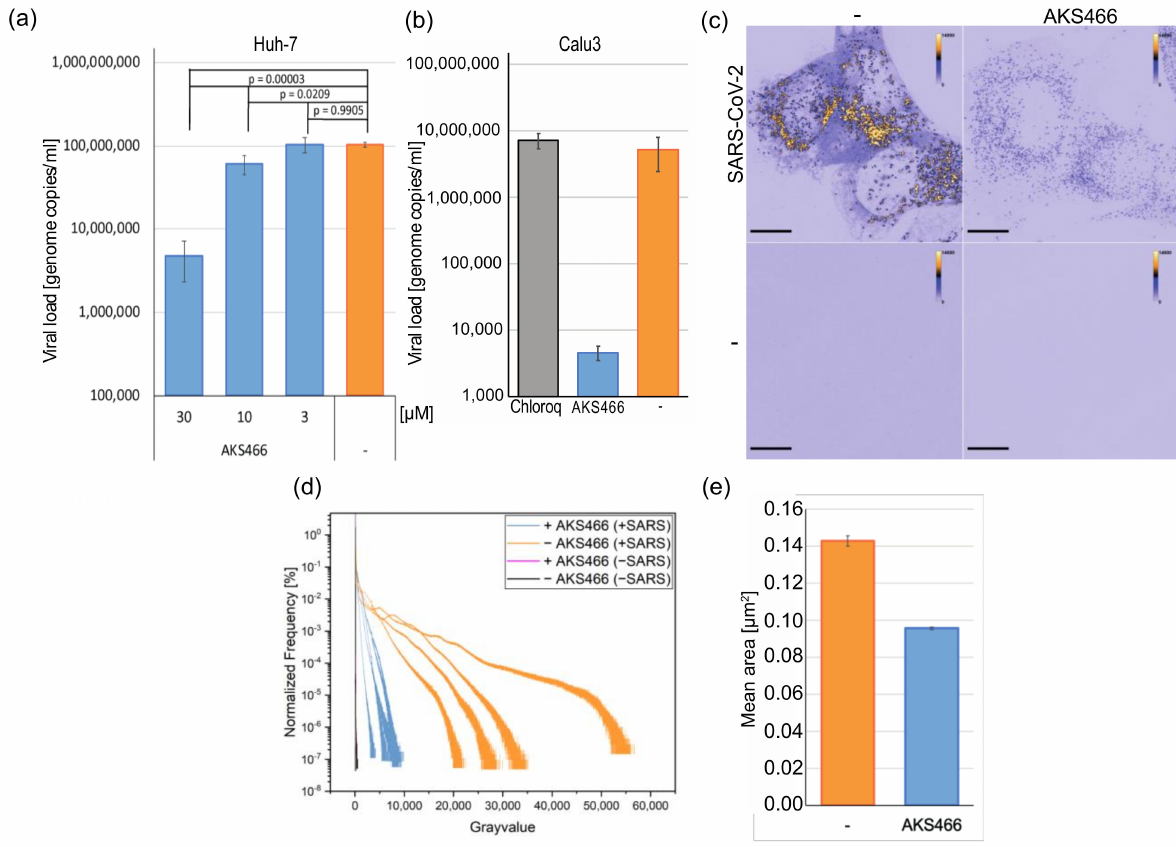
Figure 3. AKS466 inhibits SARS-CoV-2 replication. ( a ) Huh-7 were incubated with 3, 10, 30 µ M AKS466, and ( b ) Calu-3 cells were incubated with 30 µ M AKS466 and infected with 0.5 µ L SARS-CoV- 2. Cell culture supernatants were harvested after 3 days, and viral loads were determined by RTqPCR. Chloroq: Chloroquine (30 µ M). ( c ) Maximum intensity projections of SARS-CoV-2 FISH confocal fluorescence images of Huh-7 cells. In infected cells (top row), fluorescence intensity decreases upon AKS466 treatment. Only a minor FISH background signal is detectable in non-infected cells (lower row). Scale bar 10 µ m. ( d ) Quantification of relative fluorescence intensity frequencies of RNA FISH signal from SIM raw data from different experiments with SARS-CoV-2-infected (+SARS) and non- infected (-SARS) cells in the presence (+AKS466) and absence (-AKS466) of AKS466. ( e ) Significant reduction in the mean area of the individual (+)-RNA FISH clusters upon AKS466 treatment in SARS-CoV-2-infected